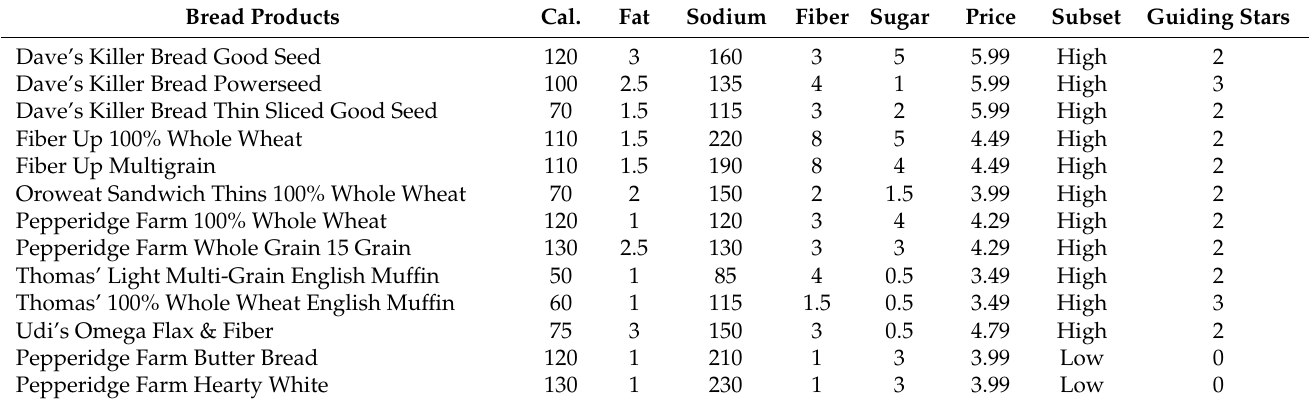
Table A1. Bread products, nutritional and price information, and subsets in the